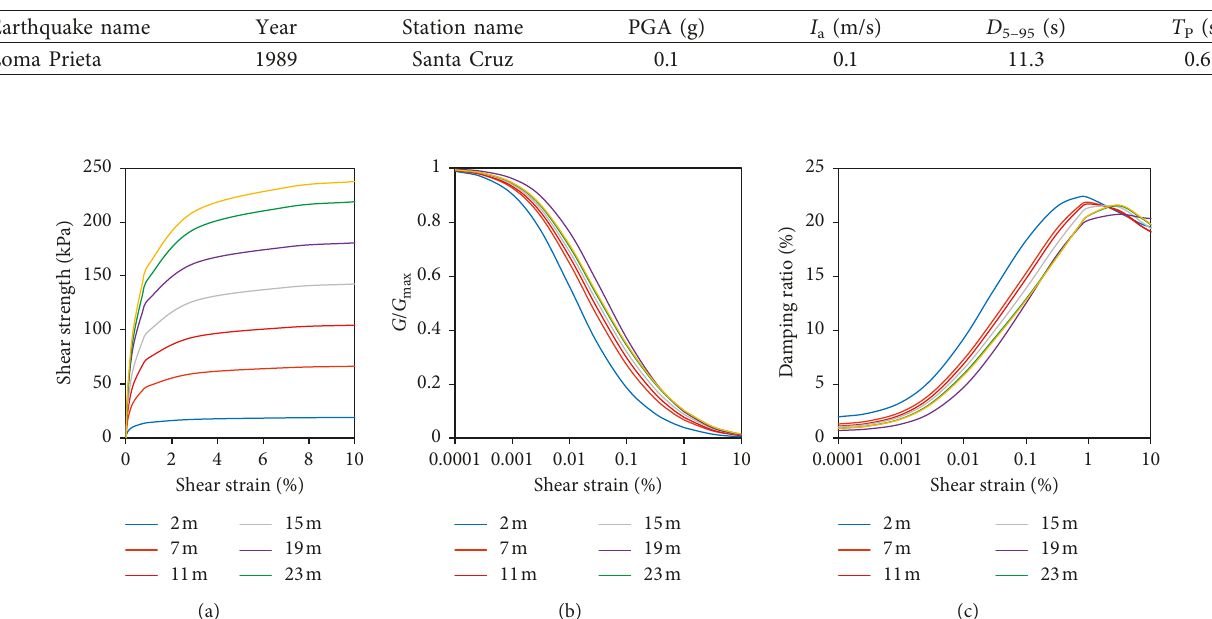
Figure 4: (a) Measured shear wave velocity profile [9]. (b) Input motion acceleration-time history and response spectra at the base of the centrifuge container. Table 2: Characteristics of input motion [9].